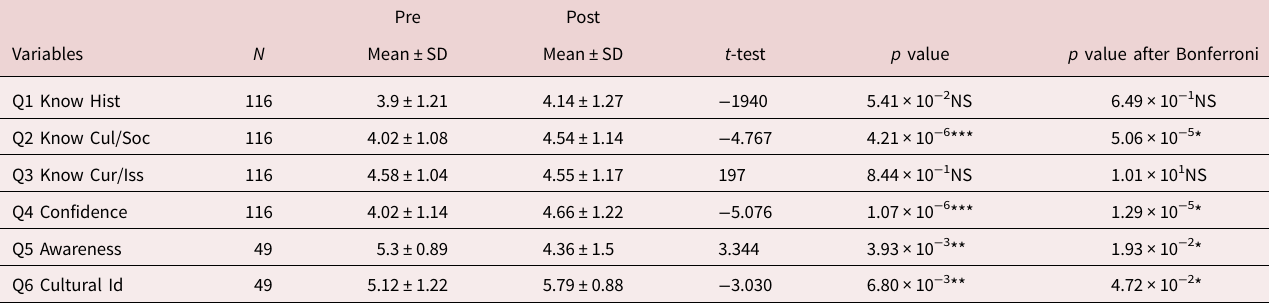
Table 4. T -test conducted of comparison between pre- and post-workshop scores on variables (attitudinal change experienced) for 4 th year